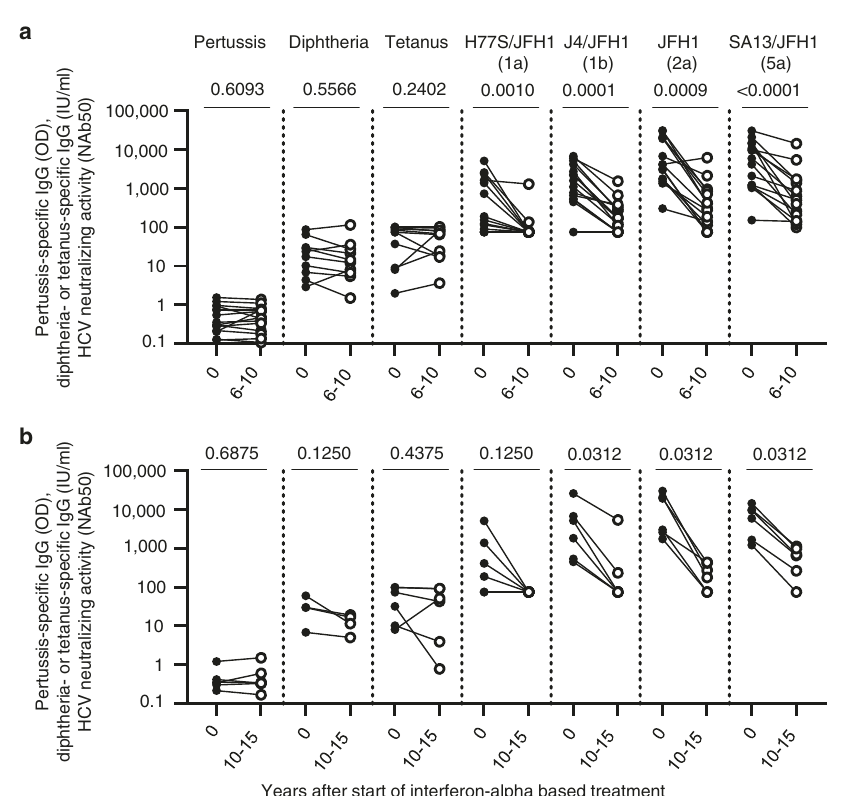
Fig. 2 | Patients with declining HCV-neutralizing activity maintain antibodies against pertussis, diphtheria, and tetanus toxoid antigens. a , b Humoral immune responses to pertussis, diphtheria, and tetanus toxoid antigens and HCV- neutralizing activity. Neutralization of HCVcc with JFH1 backbone and core-NS2 sequences of H77S (genotype 1a), J4 (genotype 1b), JFH1 (genotype 2a), and SA13 (genotype5a)wasassessed.Two-sided p